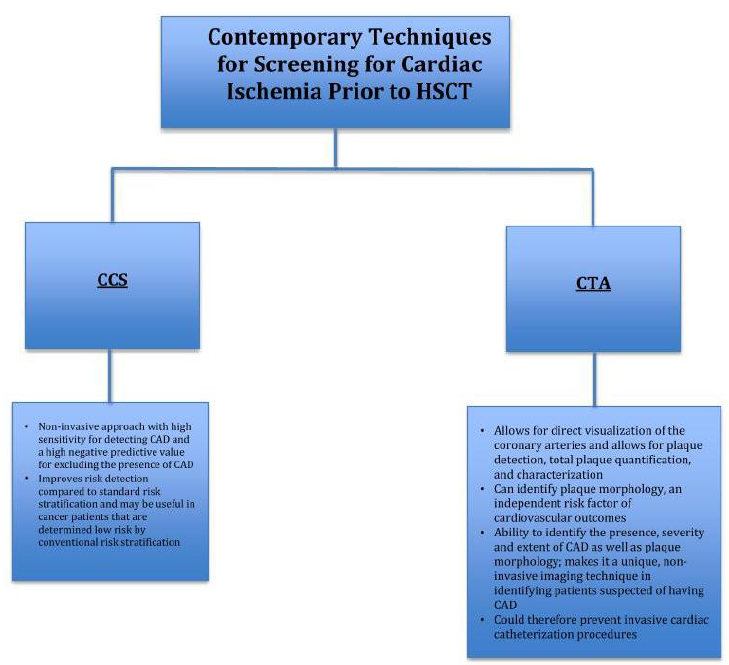
Figure 2. Contemporary techniques for screening for cardiac ischemia prior to HSCT. HSCT, hematopoietic stem cell transplant; CAD, coronary artery disease; CCS, coronary calcium scoring; CCTA, cardiac computed tomography